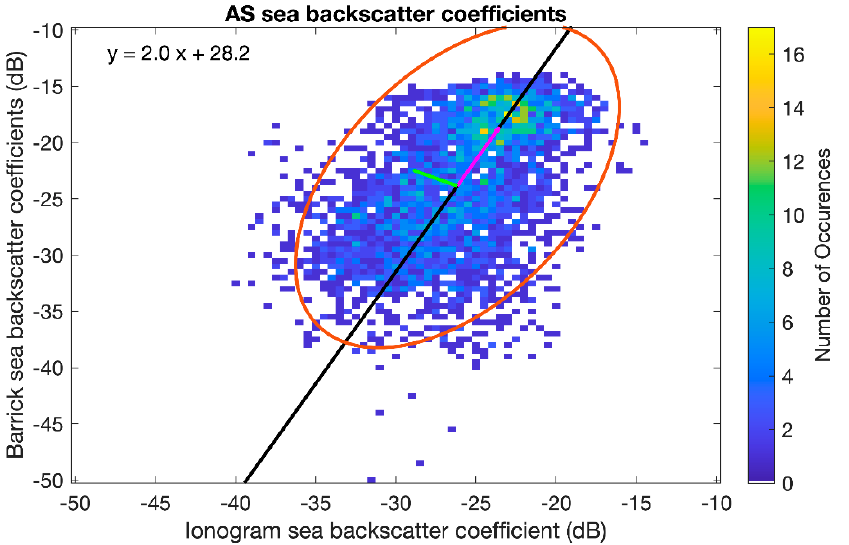
Figure 15. Scatter plot of the Alice Springs sea surface backscatter coefficients from the Barrick method accounting for a wave height bias of − 0.2 m versus the ionogram method using data from September 2015 and March 2016. A line of best fit is shown in black, with the corresponding equation in the top left corner and a 95% confidence error ellipse shown in red. The eigenvectors of the covariance matrix are shown in green and magenta.